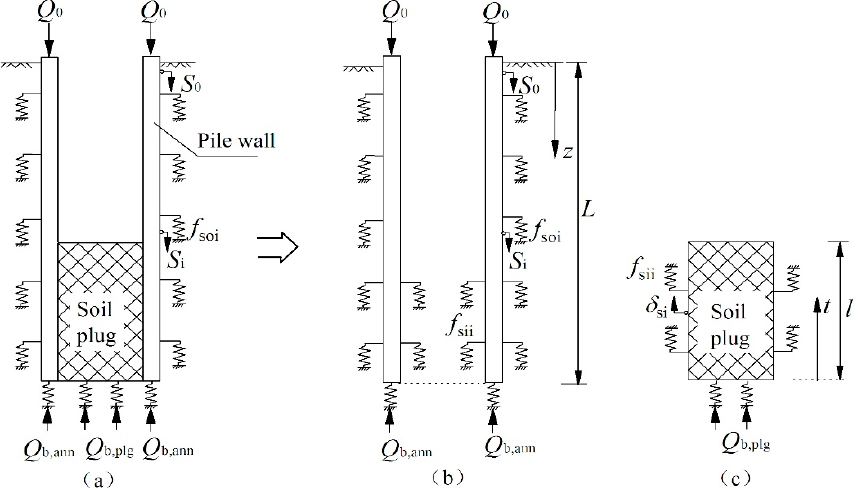
Figure 1. Load transfer diagram for open-ended pipe pile. (( a ) Open-ended pile defined as “pile in pile” system, ( b ) pile annulus defined as “outer pile”, ( c ) soil plug defined as “inner pile”.).